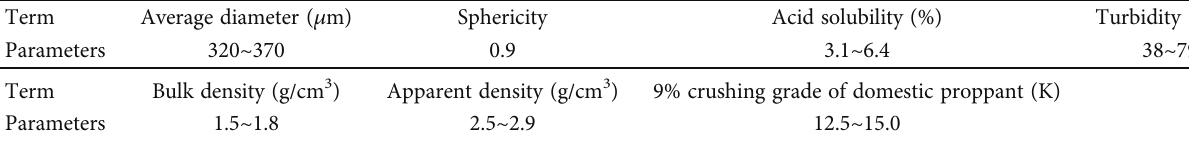
Table 2: 40/70 mesh ceramsite proppant performance parameters.